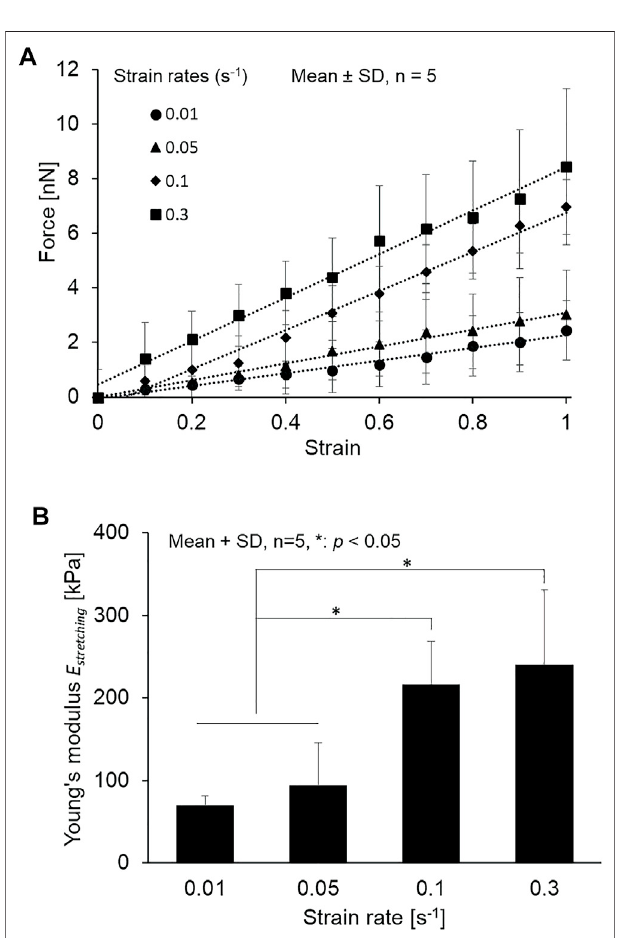
FIGURE 5 | (A) Relationship between force and strain of primary cilia at different strain rates from 0.01 to 0.3 s − 1 and the least squares fi tting (B) The Young ’ s modulus determined at different strain rates from 0.01 to 0.3 s − 1 .